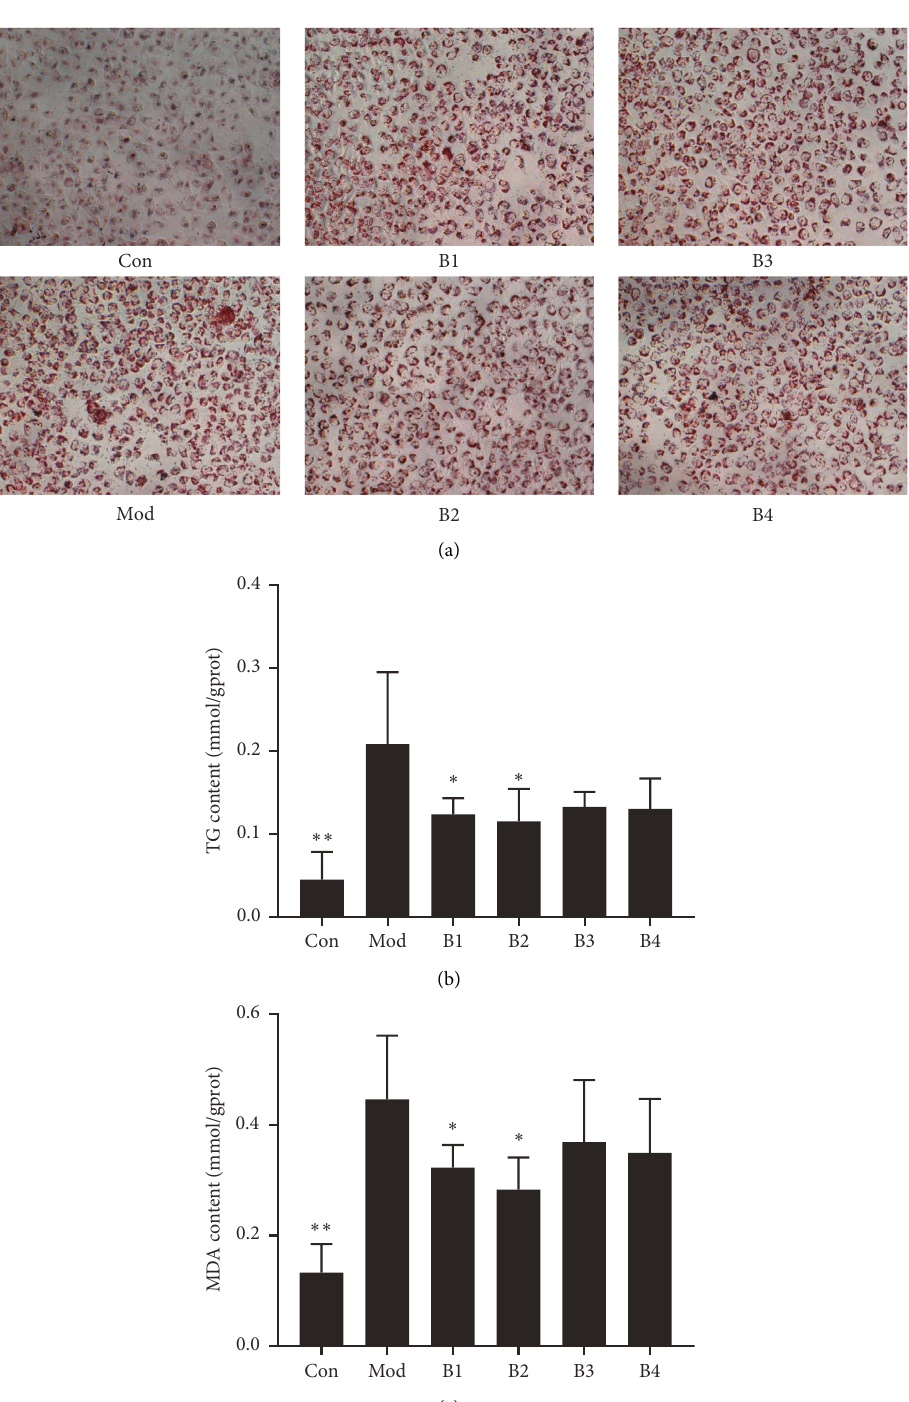
Figure 3: Effect of different polar fractions of BHD extracts on oleic acid-induced steatosis in L02 cells. (a) Intracellular lipid ac- cumulation was detected by the Oil Red O staining method using an inverted microscope (400 × ). (b) Intracellular TG was assayed in L02 cells. (c) Intracellular MDA was assayed in L02